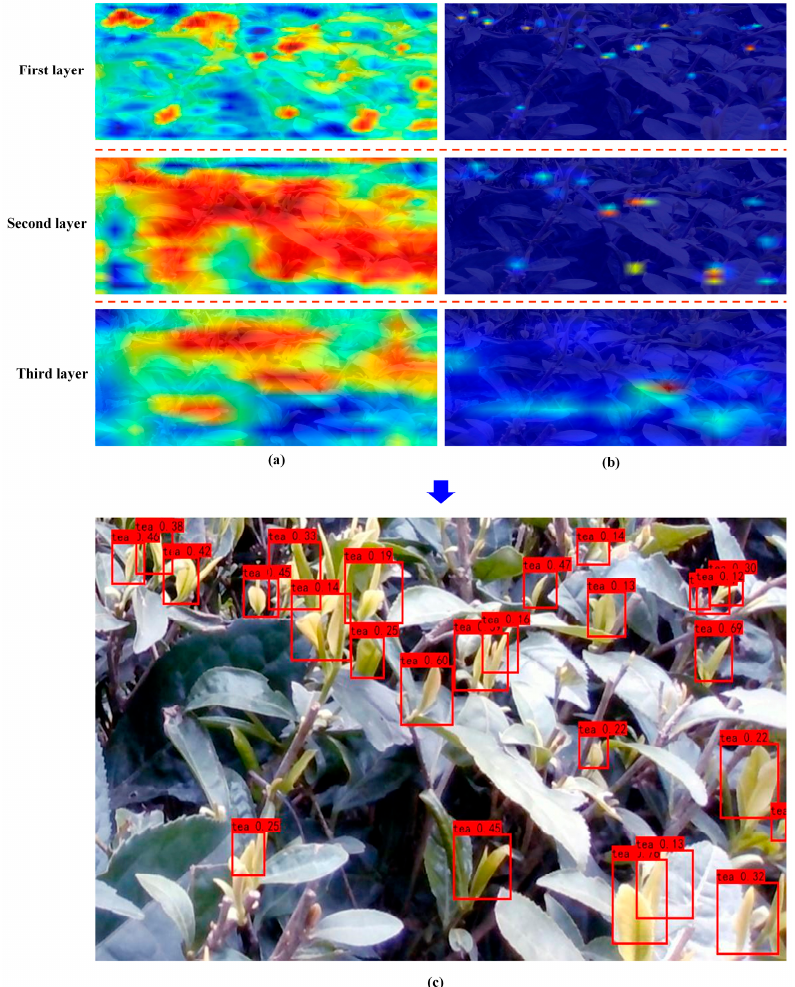
Figure 10. Prediction mechanism. ( a ) Heat maps of feature layers (warmer colors for predicted tar- gets); ( b ) Targets from the feature layers and the confidence score layer are combined; ( c ) Detected targets superimposed on the original image.